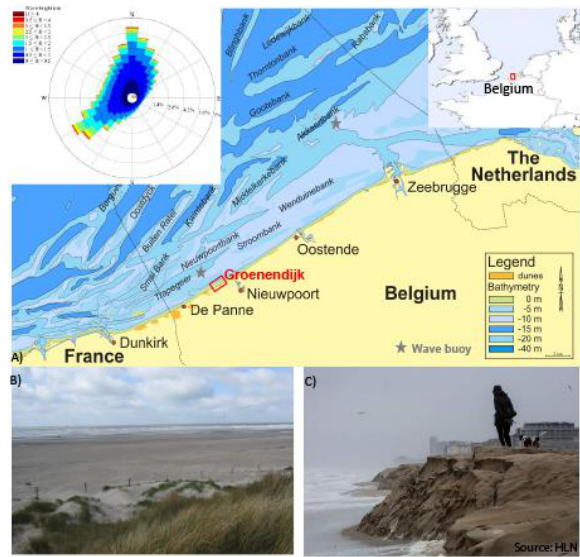
Figure 1. Map of the study site; inset: annual wave rose. Ground photographs B) before, and C) immediately after the storm.